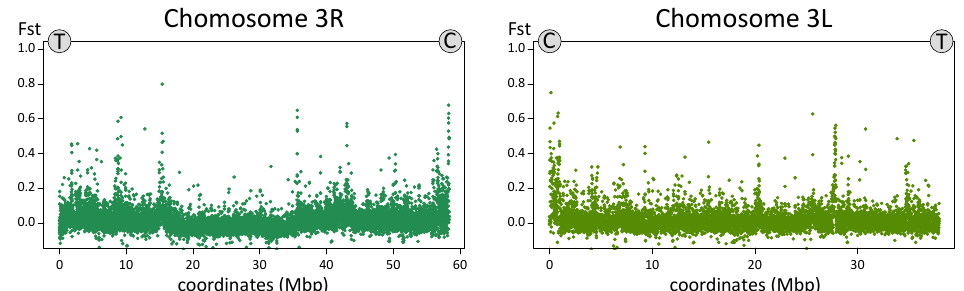
Figure 7. Level of genetic di ff erentiation (Fst) between An. messeae (n = 5) and An. daciae (n = 5) along